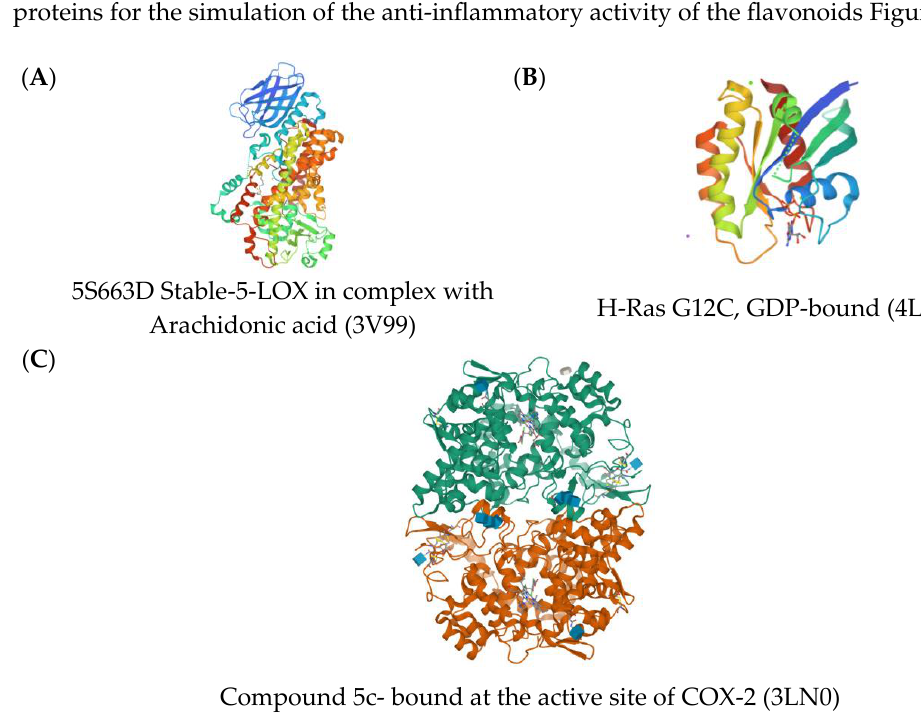
Figure 4. Three-dimensional crystal structures of ( A ) 5S663D Stable-5-LOX in complex with Ara- chidonic acid (3V99); ( B ) H-Ras G12C, GDP-bound (4L9S); ( C ) compound 5c-S bound at the active site of COX-2